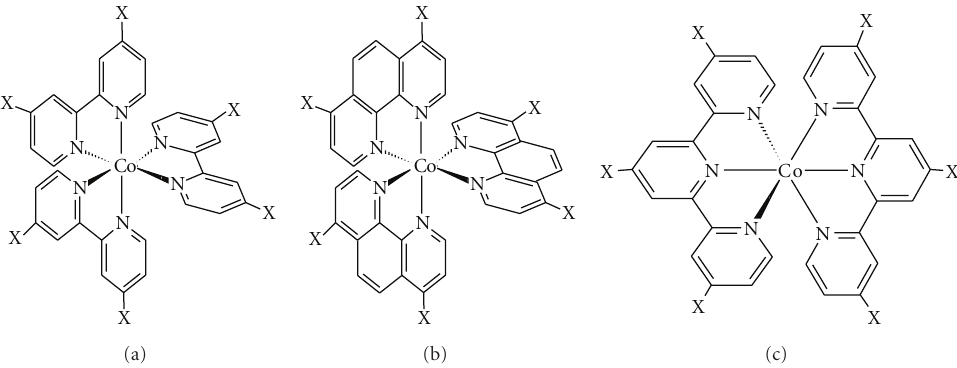
Figure 7: Structure of polypyridilic Co(II) complexes: (a) X = Tert-butyl (DTB), Methyl (DMB), H (bpy). (b) X = H (phen). (c) X = Tert-butyl (tTbterpy), Ethyl (tEterpy).